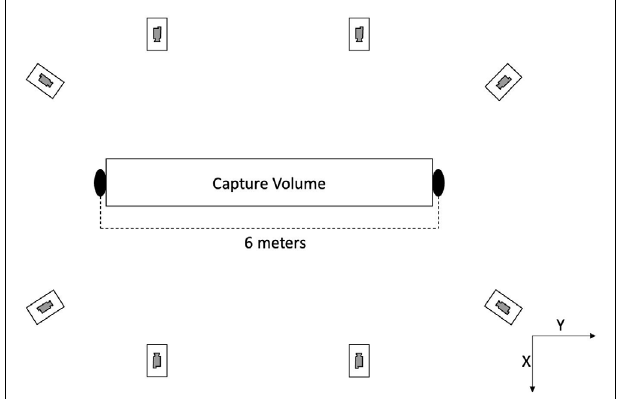
FIGURE 1 | Illustrating data capture experimental